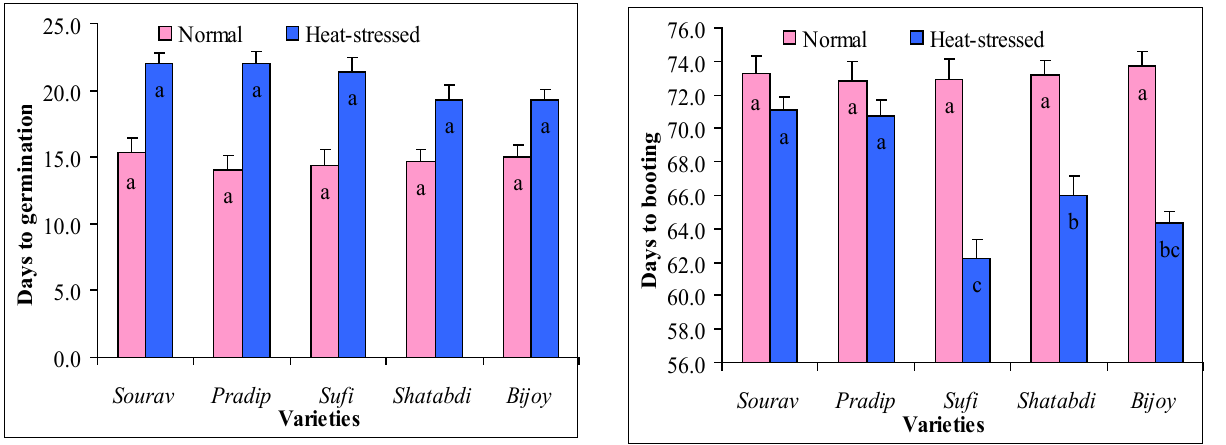
Fig. 3. Days to booting of different wheat varieties under normal and heat stressed condition. Mean (±SD) was calculated from three replicates for each treatment. Bars with different letters are significantly different at P < 0.05 applying LSD test